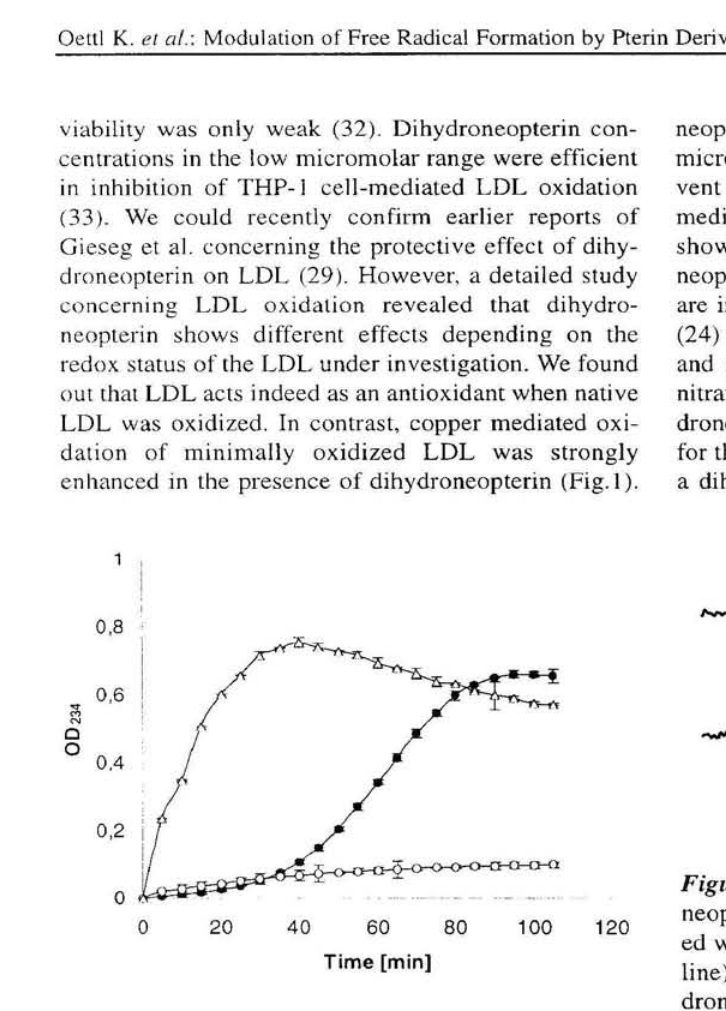
Figure 1: Modulation of copper-induced LDL oxida- tion by dihydroneopterin. Native LDL (44 μg/mL LDL protein, lipid hydroperoxides < 2 nmol/mg pro- tein) was oxidized with 50 μΜ Cu 2+ in the absence (·) or in the presence (O) of 100 μΜ dihydroneopterin. The same experiment was performed with minimally oxidized LDL (Δ), (8 nmol/mg protein lipid hydroper- oxides). The control curve of the latter looks essential- ly like native LDL.